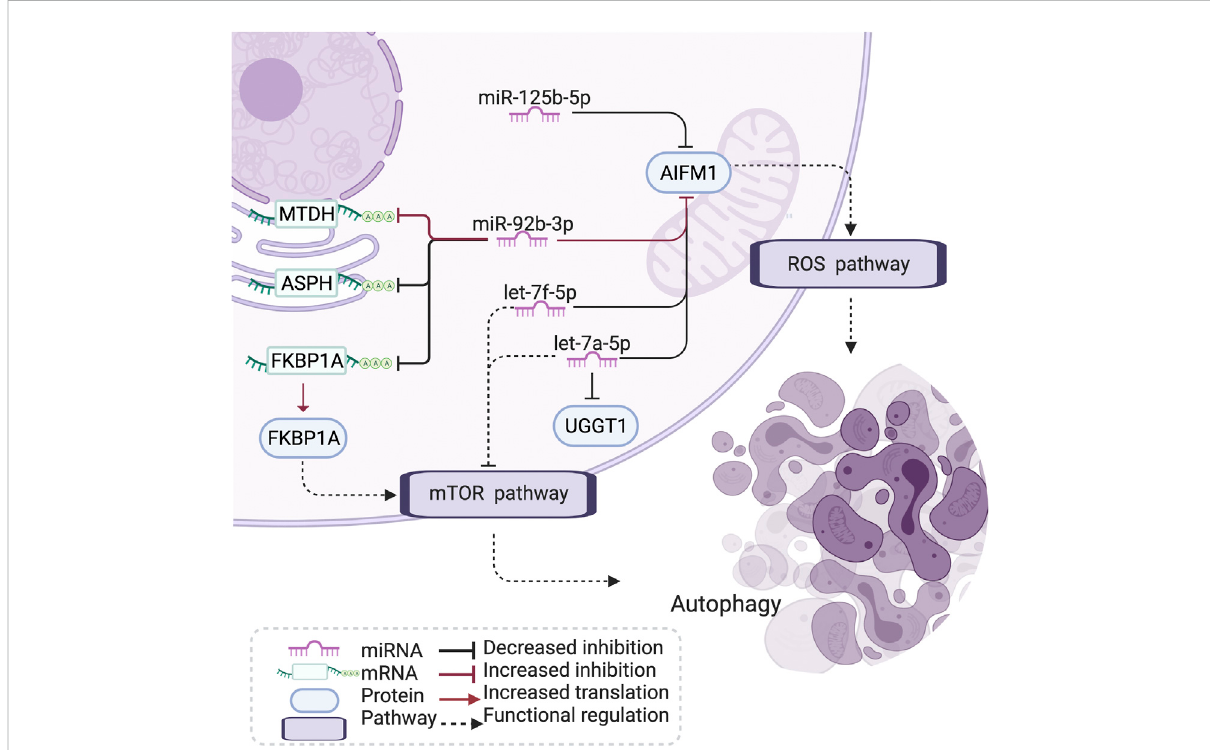
FIGURE 5 Let-7-AIFM1-FKBP1A pathway and its potential effect in COPD. The let-7 family has an increased correlation with AIFM1 protein expression in COPD, which may induce a stronger inhibition than through the ROS and mTOR pathway to in fl uence autophagy and cell differentiation in COPD. AIFM1: apoptosis-inducing factor mitochondria-associated 1, FKBP1: FKBP prolyl isomerase 1A, MTDH: metadherin, ASPH: aspartate β -hydroxylase, UGGT1: UDP-glucose:glycoprotein glucosyltransferase 1, ROS: reactive oxygen species, mTOR: mammalian target of rapamycin, COPD: chronic obstructive pulmonary disease. Created using